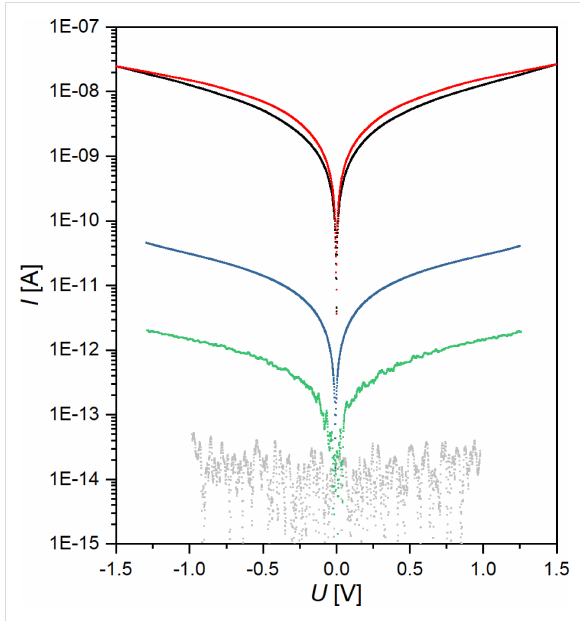
Figure 3: Log current vs voltage curves of Ru(TP) 2 -complex wire devices (green), multiple-Ru(MPTP) 2 –AuNP devices (blue), single- Ru(MPTP) 2 –AuNP devices (red/black, data taken from [15]), and empty nanogaps representing the noise level